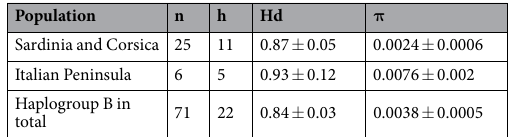
Table 1. Summary statistics of molecular diversity within haplogroup B of European red deer; n – number of individuals, h – number of haplotypes, Hd – haplotype diversity, π – nucleotide diversity. Values are based on all available individual cyt b sequences of haplogroup B. For Sardinia and Corsica these were 22 ancient sequences from this study and three contemporary sequences from Ludt et al . 4 . The overall number of 71 includes the sequences from this study and all individuals from GenBank. Because in GenBank, often only a single sequence is given per haplotype, we reconstructed individual numbers from the original